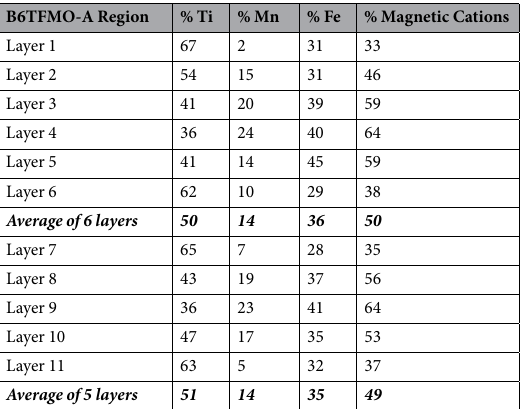
Table 2. The relative B-site proportions of Ti, Mn and Fe quantified by taking horizontal line profiles of the EDX data across regions indicated in Fig. 5(c).